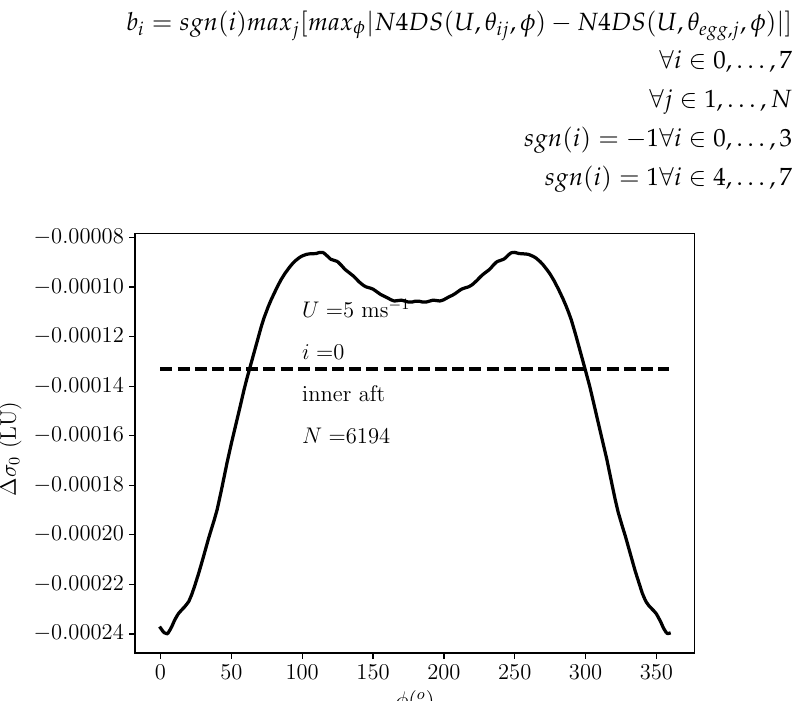
Figure 3. Solid line: expected σ 0 deviations in linear units (LU) from σ 0, egg for the inner (HH-Pol) aft slice with index 0 as a function of the relative wind direction ( φ ) simulated with NSCAT4DS at a wind speed equal to 5 ms − 1 . Dashed line: average value of the solid line. N represents the number of samples used in this simulation. The data used are from the orbit with number